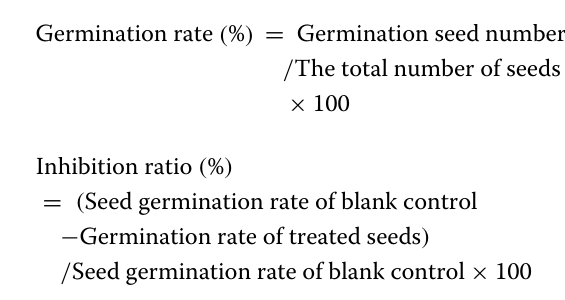
Table 1 Parasitic rate, O. aegyptiaca number, fresh weight and biomass of different treatment in pot experiment